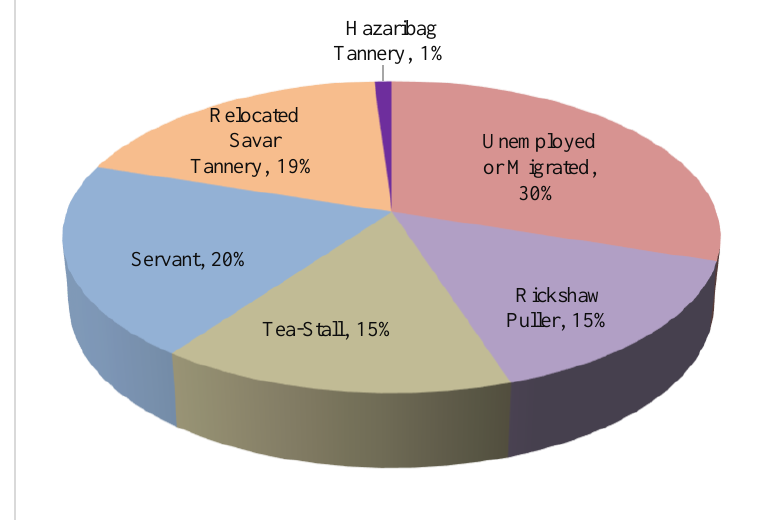
Figure 6: Change in Employment and Livelihood